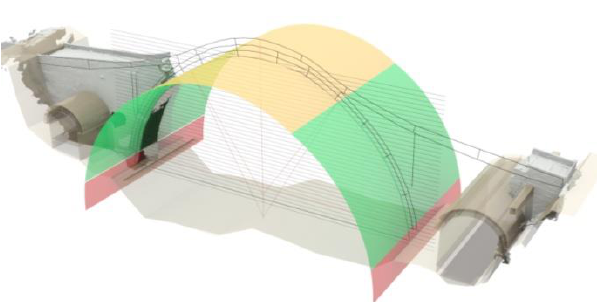
Figure 15. 3D verification, in relation to the ruins geometry of the original outline tracing of the main arch, by using the image-based generated 3D